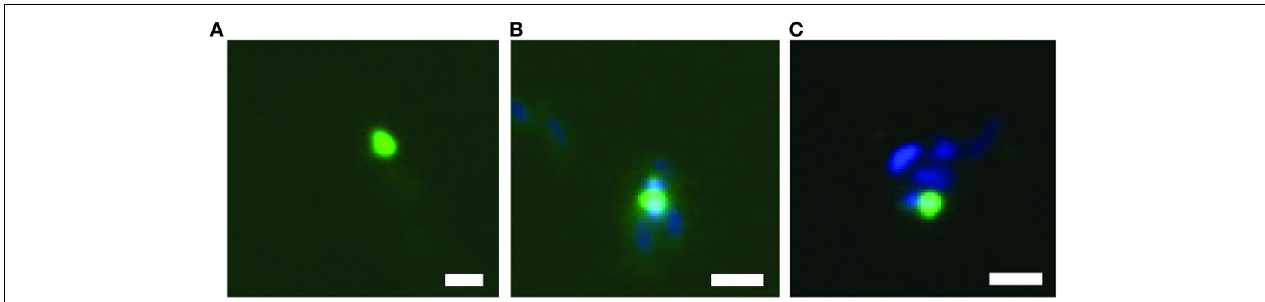
FIGURE 6 | Fluorescence in situ hybridization of bacteria of the BD1-5/SN-2 division, showing free living cells (A) and cells attached to other bacteria (B,C). Scale bar = 1 µ m.